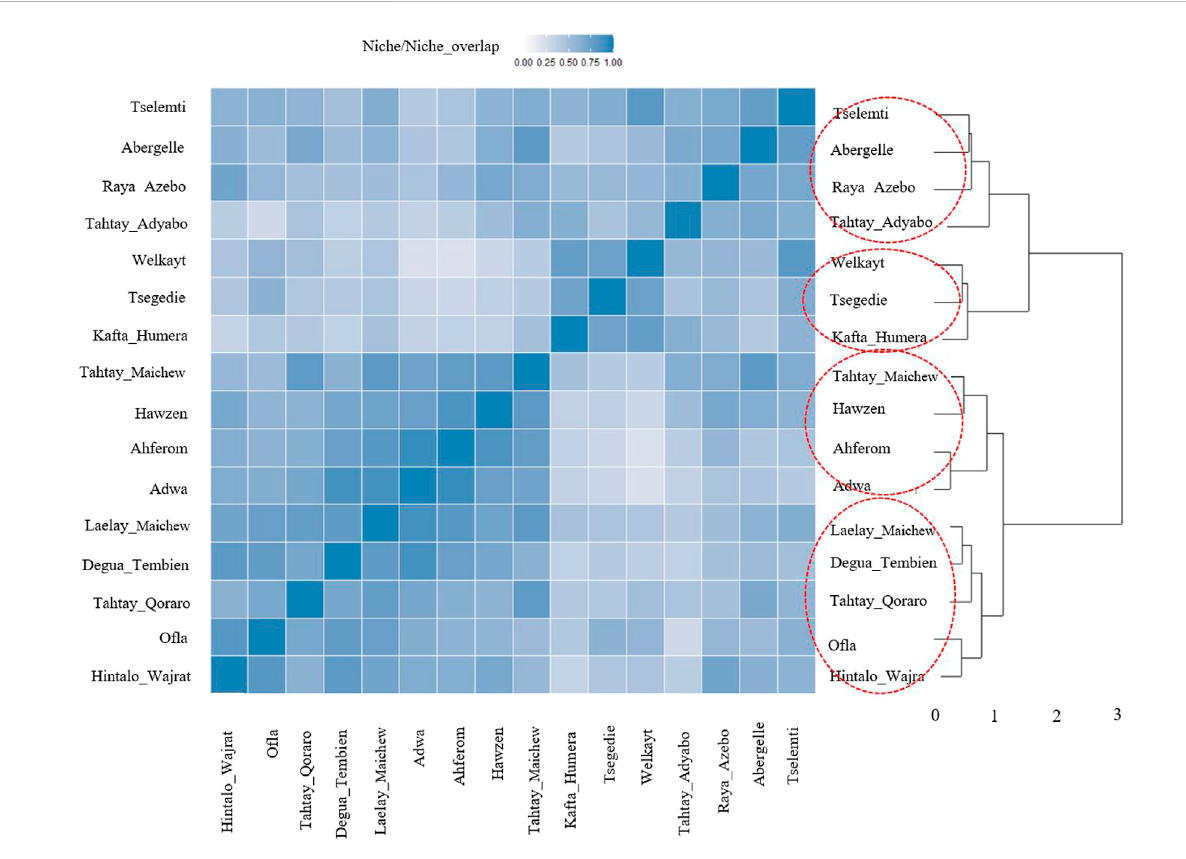
FIGURE 10 Dendrogram and heatmap of niche overlap statistics (I) between suitability maps for individual